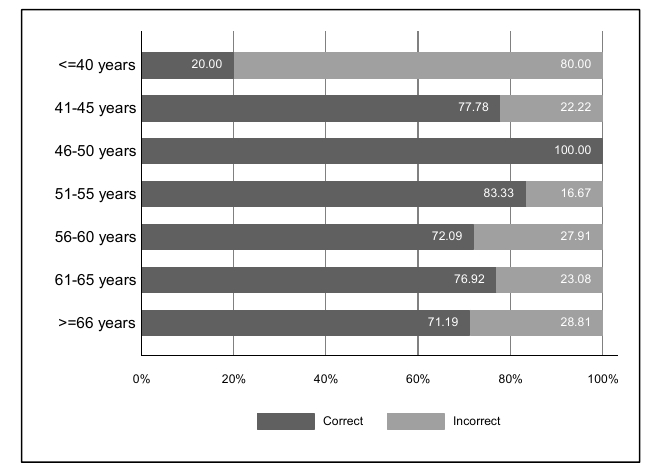
Figure 4 Interviewer behavior for collecting administrative information II and interviewer’s